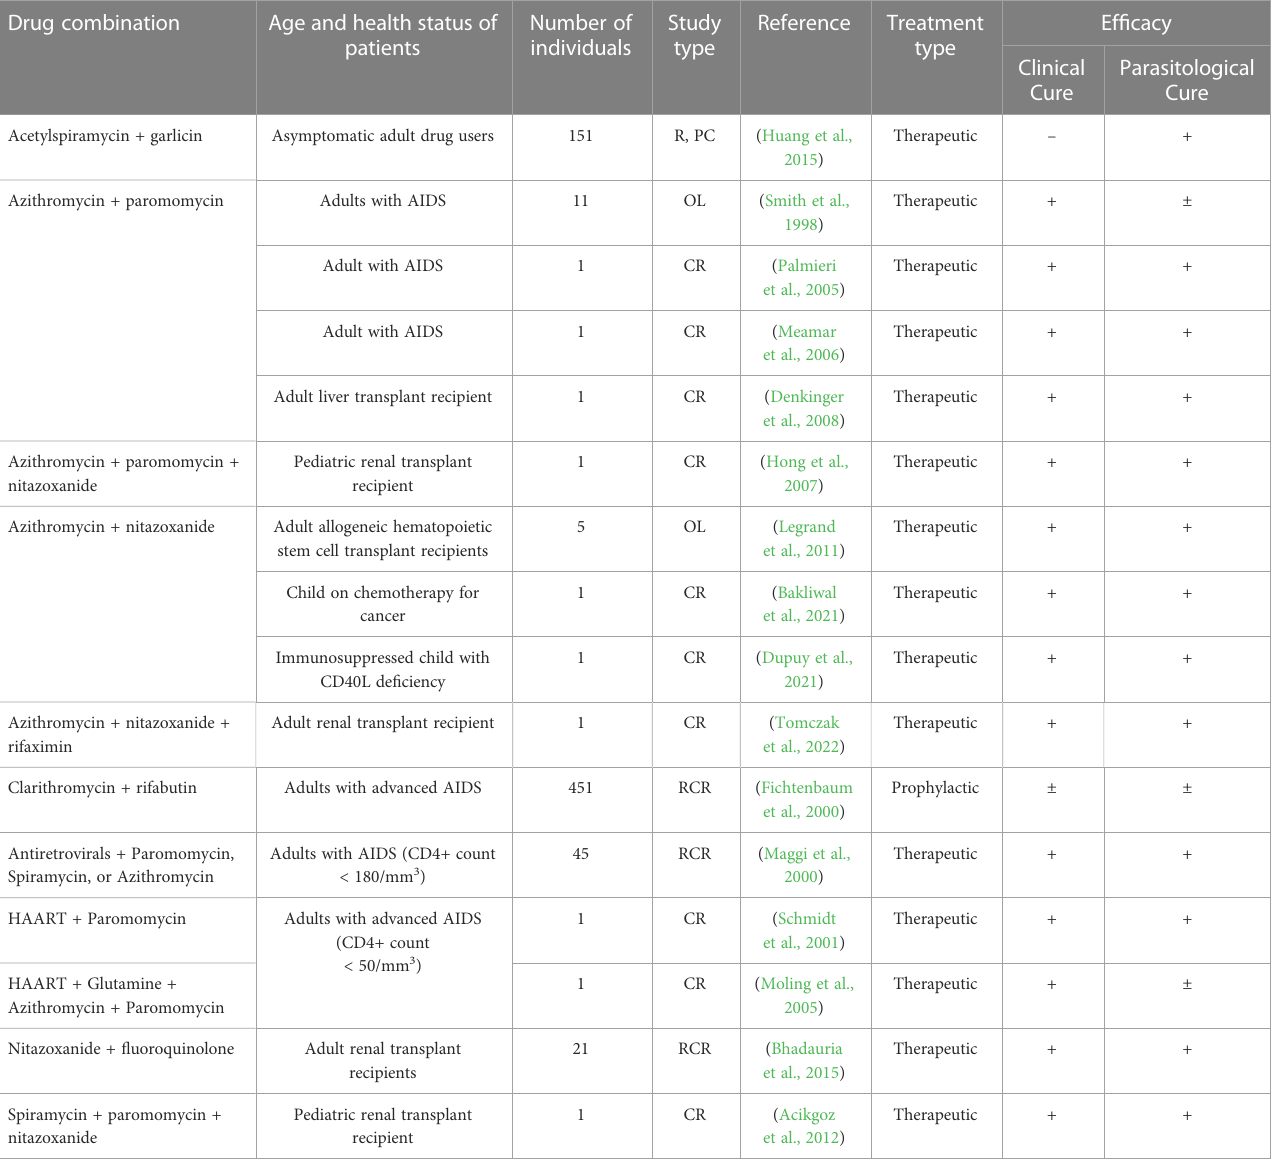
TABLE 3 Ef fi cacies of various combination therapies tested against human cryptosporidiosis. Drug